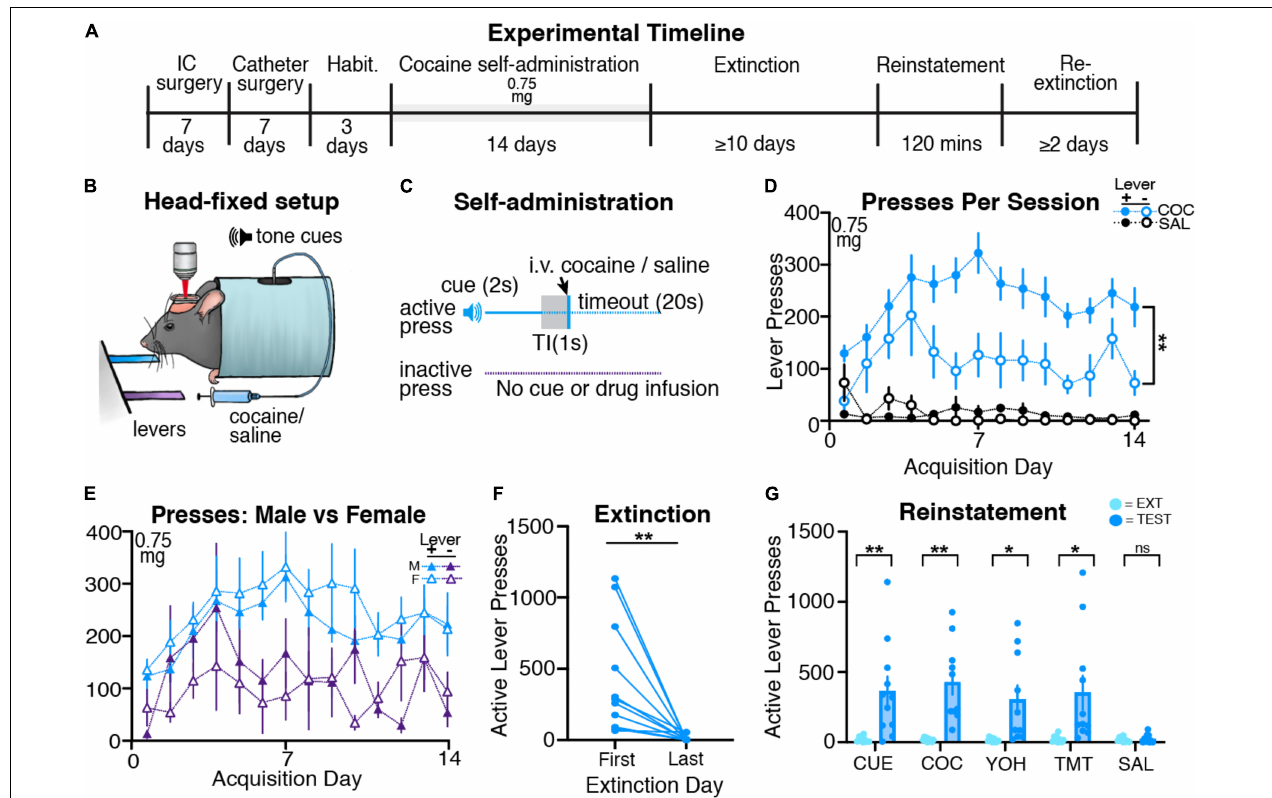
FIGURE 2 | Head-restrained mice self-administer cocaine and display extinction and reinstatement of cocaine seeking. (A) An experimental timeline demonstrating the behavioral procedure used for head-restrained cocaine self-administration. (B) Illustration of head fixation for cocaine self-administration experiments. Active lever presses resulted in a tone cue that predicted intravenous cocaine (0.75 mg/kg on all days) or saline. (C) Schematic for cocaine self-administration experiments, where active but not inactive lever presses resulted in a tone cue (2s), a gap in time (TI, trace interval; 1s), an infusion of cocaine or saline, and a timeout period (20s). (D) Data showing that cocaine self-administering mice pressed the active lever more than the inactive lever (** p = 0.002). (E) A comparison of active and inactive lever pressing across sexes. Male and female cocaine self-administering mice showed no differences in lever pressing across acquisition. (F) All cocaine self-administering mice significantly decreased active lever pressing from the first day of extinction to the last (** p = 0.006). (G) Mice displayed cue- (** p = 0.007), cocaine- (** p = 0.002), yohimbine- (* p = 0.017), and predator odor (TMT; * p = 0.019)- induced reinstatement of active lever pressing as compared with the previous extinction test. Mice did not reinstate following an injection of